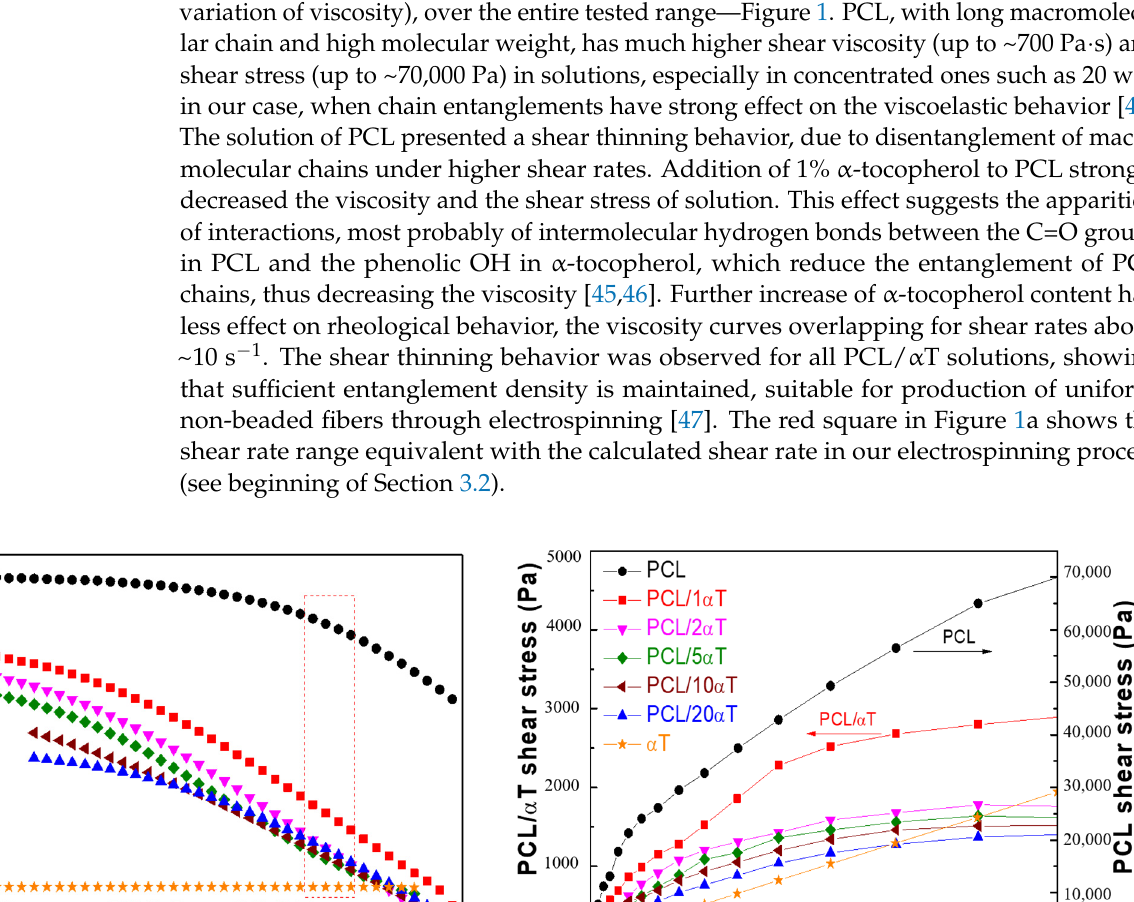
Figure 2. Angular frequency dependence of storage (G ′ , filled symbols) and loss (G ″ , open symbols) moduli for the PCL solutions containing α -tocopherol. Figure 2 showed typical liquid behavior of α -tocopherol, with loss modulus, G ″ (which describes the viscous character of material), being much higher than the storage modulus, G ′ . Rheology of PCL solution indicated an important contribution of elasticity, the values of G ′ being very close to those of G ″ . However, the behavior is predominantly viscous (liquid-like), with G ″ > G ′ on almost entire frequency range. A crossover point appeared at ω = 123.6 rad/s, where G ′ = G ″ = 3695 Pa; this indicates a behavior of entangled polymer solution. The dynamic moduli decreased with increasing amounts of tocopherol in the PCL solutions, the effect being much stronger for the storage modulus, G ′ . There- fore, structuration of PCL macromolecular chains is reduced under the effect of tocoph- erol, as mentioned before, diminishing the elastic behavior of the solutions. Interesting to note is that if the addition of only 1 wt% α -tocopherol strongly decreased the viscosity